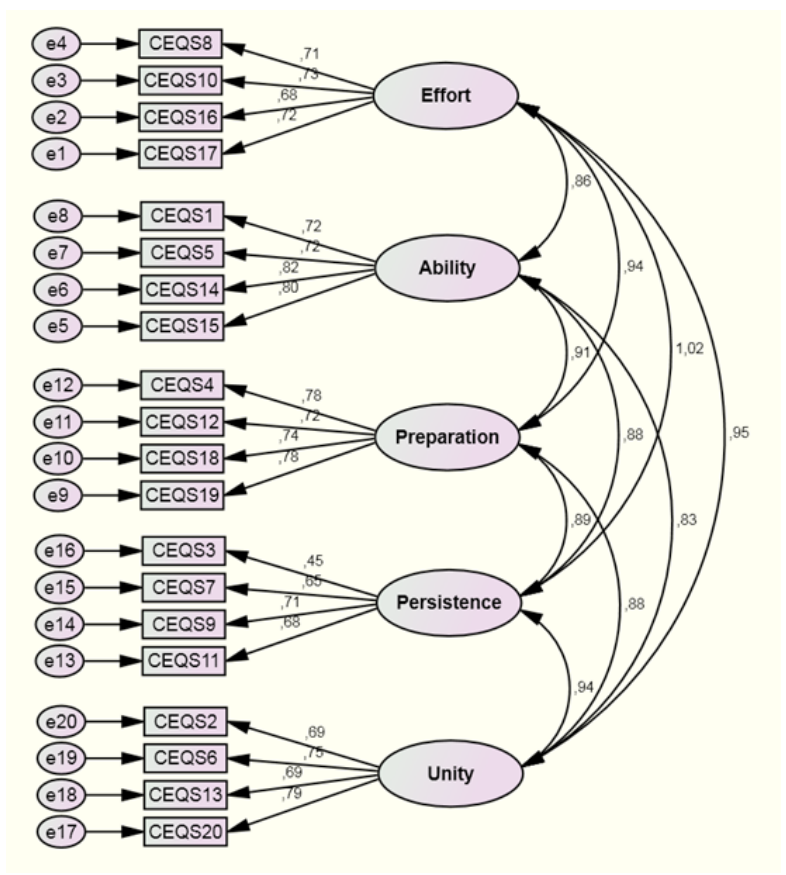
Figure 1. The factor structure and interfactor correlations of the five- factor, 20-item